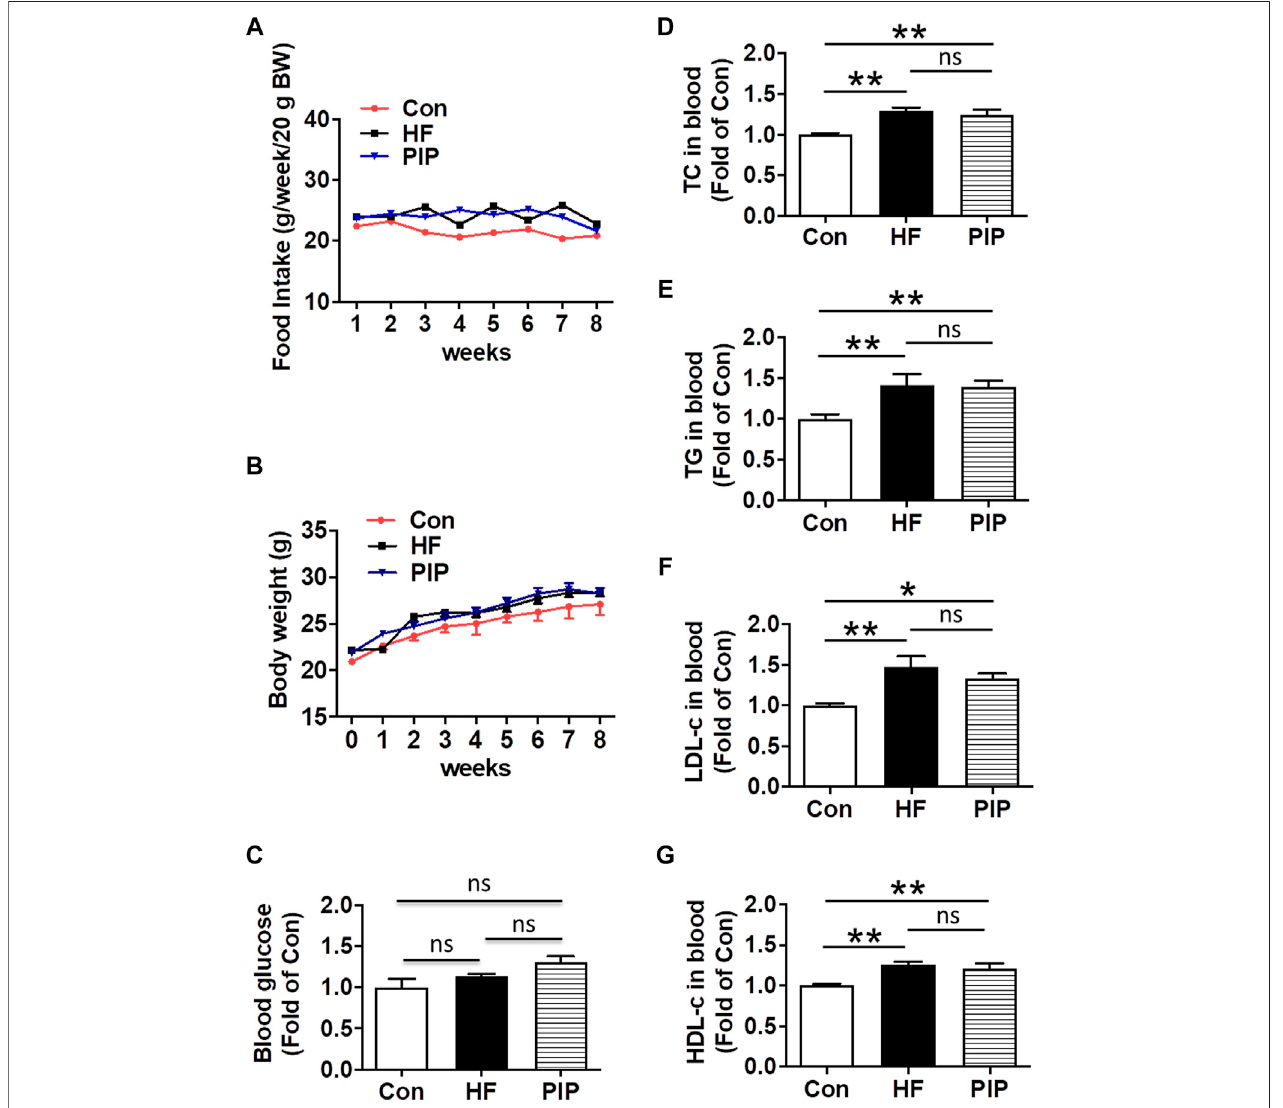
FIGURE1| Effectsoflow-dosepiperlongumineadministrationonfoodintake,bodyweight,fastingbloodglucoseandlipidlevelsinHFD-fedmice.MaleC57BL/6J mice at 8 weeks of age were randomly allocated to three groups and fed with high-fat rodent chow with or without receiving an intraperitoneal injection of low-does piperlongumine (0.25 mg/kg/d) for 8 weeks. After 8 weeks treatment, the mice were subjected to various analyses. (A) , Food intake during the 8 weeks experiments (n (cid:2) 8 – 11). (B) , Body weight during the 8 weeks experiments (n (cid:2) 7 – 11). (C) , Effect of piperlongumine on fasting blood glucose (n (cid:2) 7 – 9). (D – F) , Blood total cholesterol (TC) levels, triglyceride (TG) levels, low-density lipoprotein cholesterol (LDL-c) levels, and high-density lipoprotein cholesterol (HDL-c) levels after 8 weeks treatment(n (cid:2) 5 – 9).Throughout,barsrepresentmeans;errorbarsrepresentSEM.ValueswerenormalizedtoCon.* p < 0.05,** p < 0.01.Con,controlmice;HF,HFD-fed mice; PIP, HFD-fed mice treated with